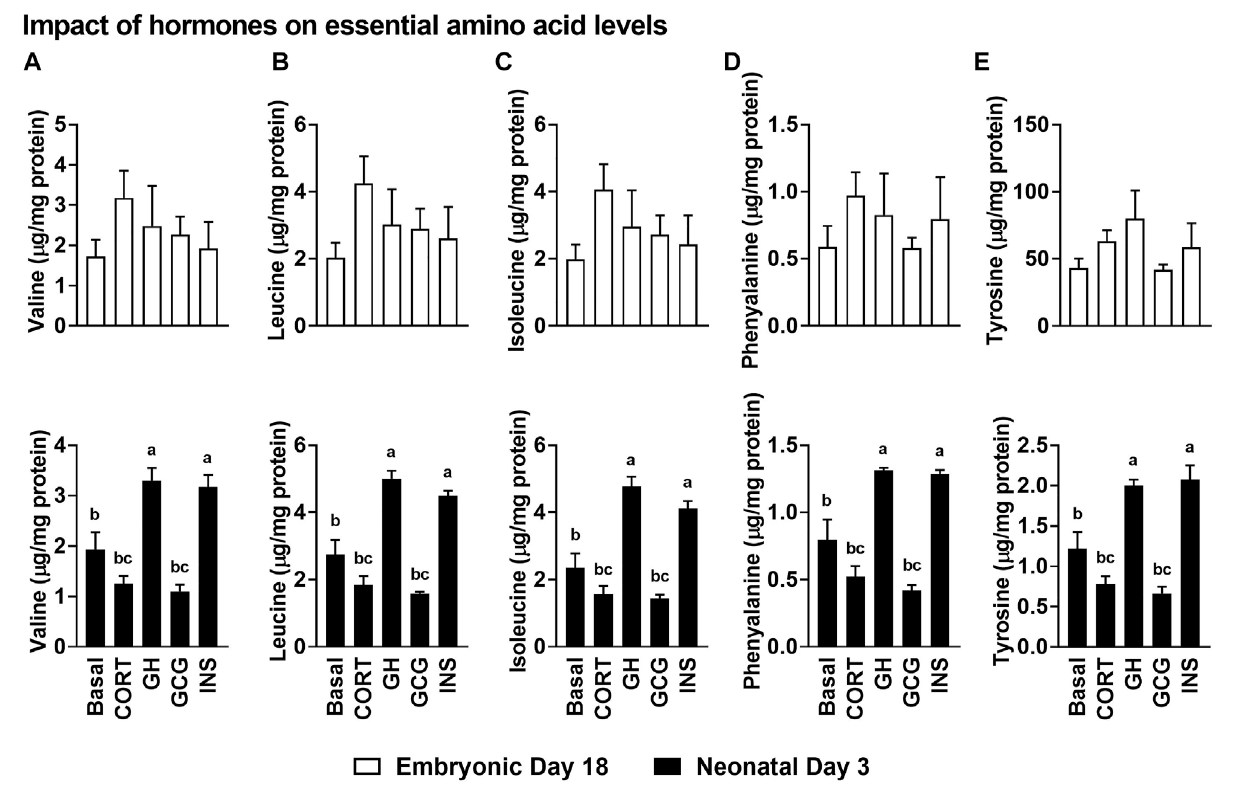
FIGURE 6 | Impact of the hormonal stimuli on the essential amino acid content of isolated hepatocytes. Impact of hormones on levels of branched-chain amino acids, (A) Valine, (B) Leucine and (C) Isoleucine and the essential amino acids (D) Phenylalanine and (E) Tyrosine. All the values are Means ± SEM of four independent replicates/group. Each replicate consisted of pooled hepatocytes isolated from 2 – 3 birds. Results are considered signi fi cant at p ≤ 0.05 following one way ANOVA. Different superscripts between bars in a panel indicates statistical signi fi cance from other treatments. CORT, Corticosterone; GH, Growth hormone; GCG, Glucagon; INS,